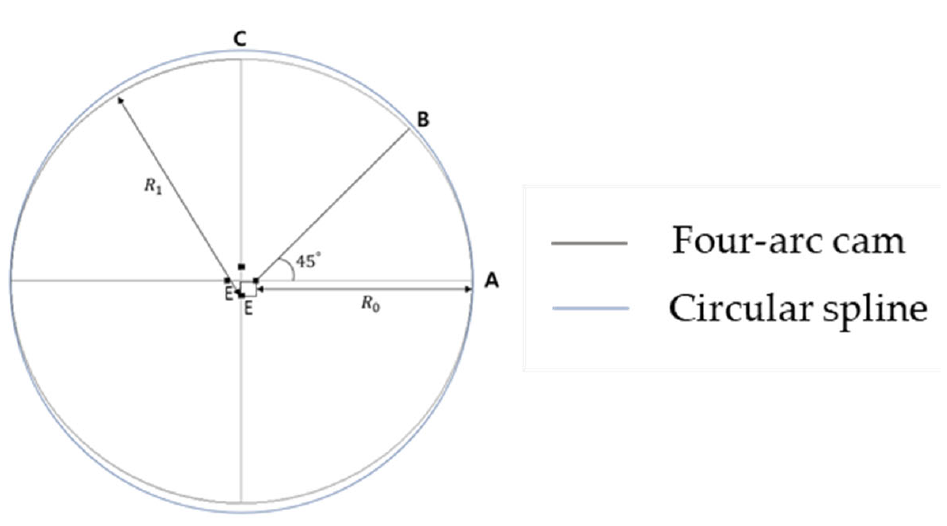
Figure 3. Four-arc combination cam Figure 3. Four ‐ arc combination cam curve